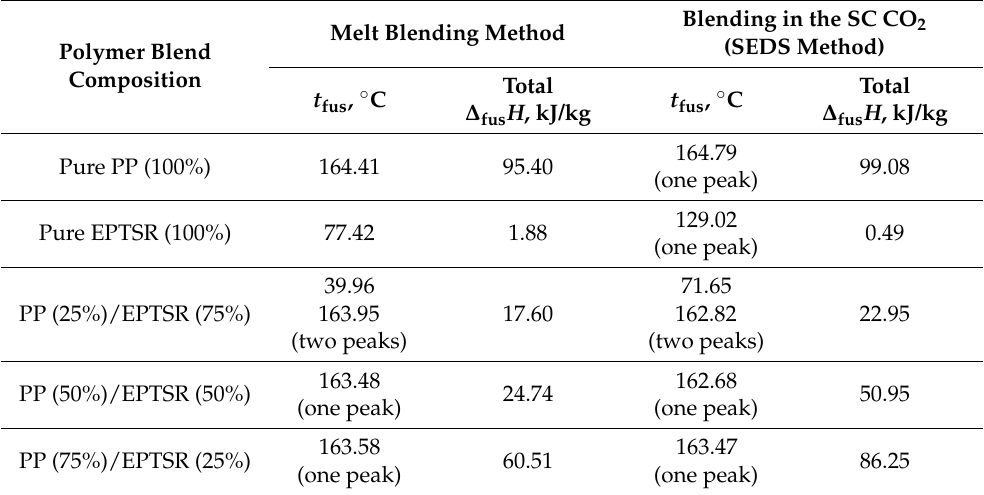
Figure 16. Melting-crystallization-melting diagram (DSC thermograms) of the 75% PP – 25% EPTSR polymer blend produced by SEDS method. Table 4. Summary of the DSC scan curve results for PP +EPTSR polymer blends at operating condition of ( t = 40 ◦ C and P = 8